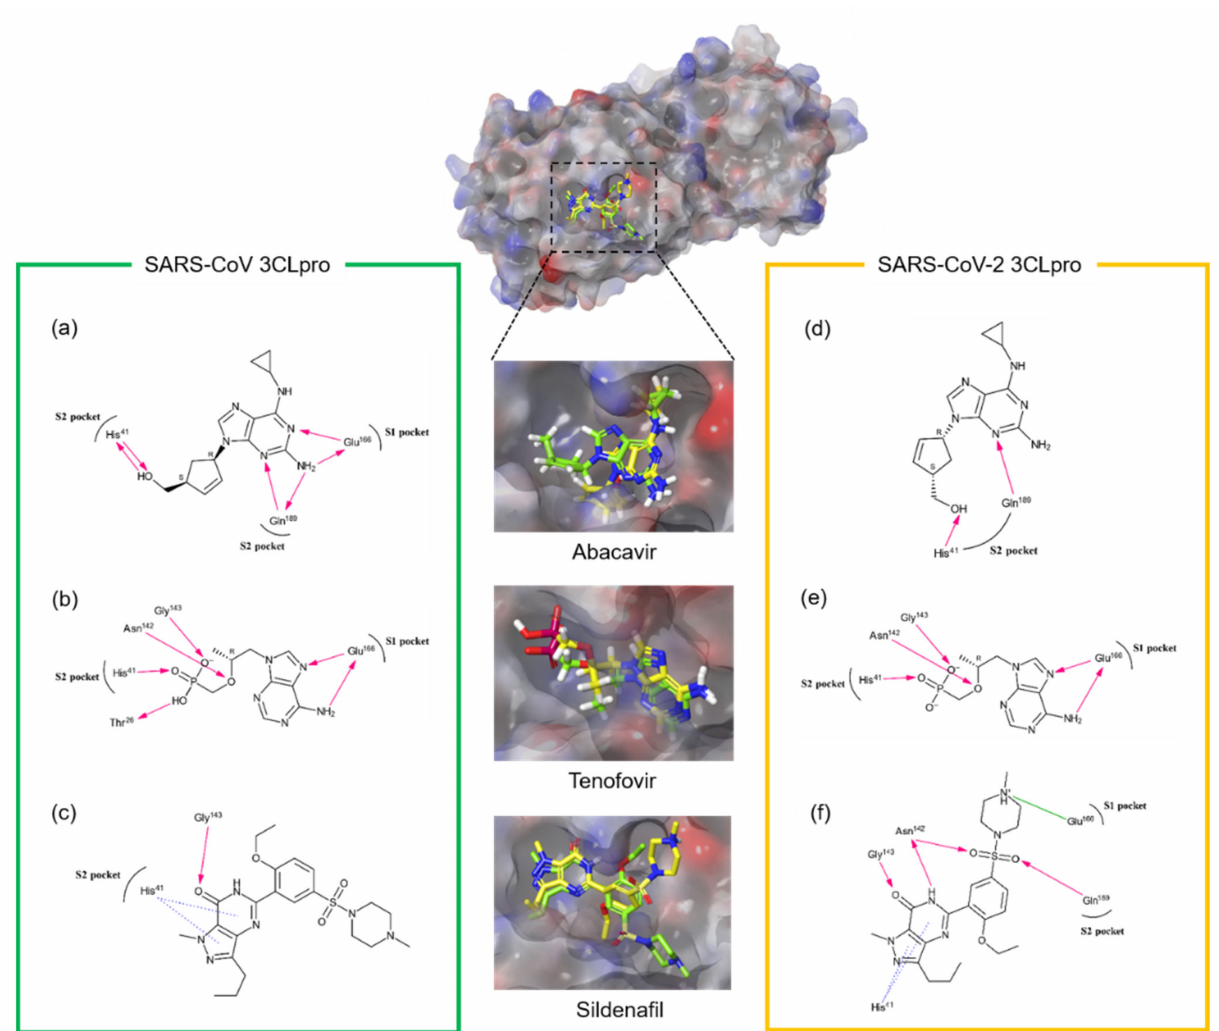
Figure 3. Predicted docking modes of each inhibitory compound in the catalytic site of SARS-CoV CLpro and SARS- CoV-2 CLpro. Docking poses of ( a , d ) abacavir, ( b , e ) tenofovir and ( c , f ) sildenafil were overlapped and depicted on the semi-transparent electrostatic surface potentials (red, negative; blue, positive; white, uncharged) of SARS-CoV (green) and SARS-CoV-2 (yellow) 3CLpros. The 2D schematic representation of each inhibitory compound was also drawn. Figures were created with Maestro v11.5.011. S1 represents the polar S1 site of 3CLpros; S2 for the hydrophobic S2 site. The pink arrows represent hydrogen bond interaction, the blue dot line is for π – π stacking and the green line is for salt